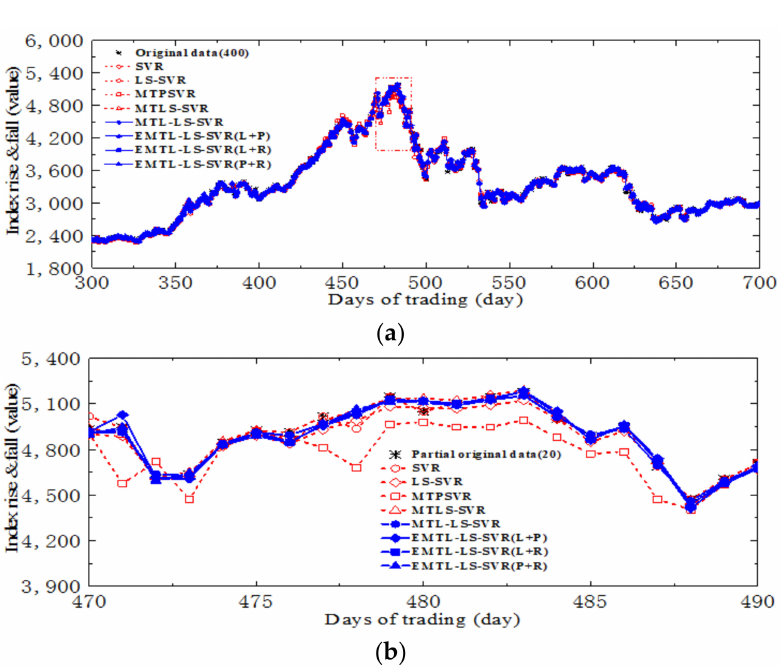
Figure 4. Predictions of different regression models on opening index for SSEC ( a ) Original figure, ( b ) Enlarged